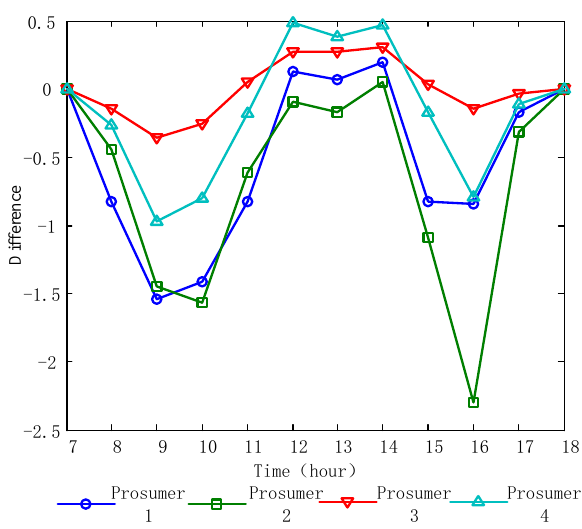
Figure 11. The comparison of internal prices before and after DR.